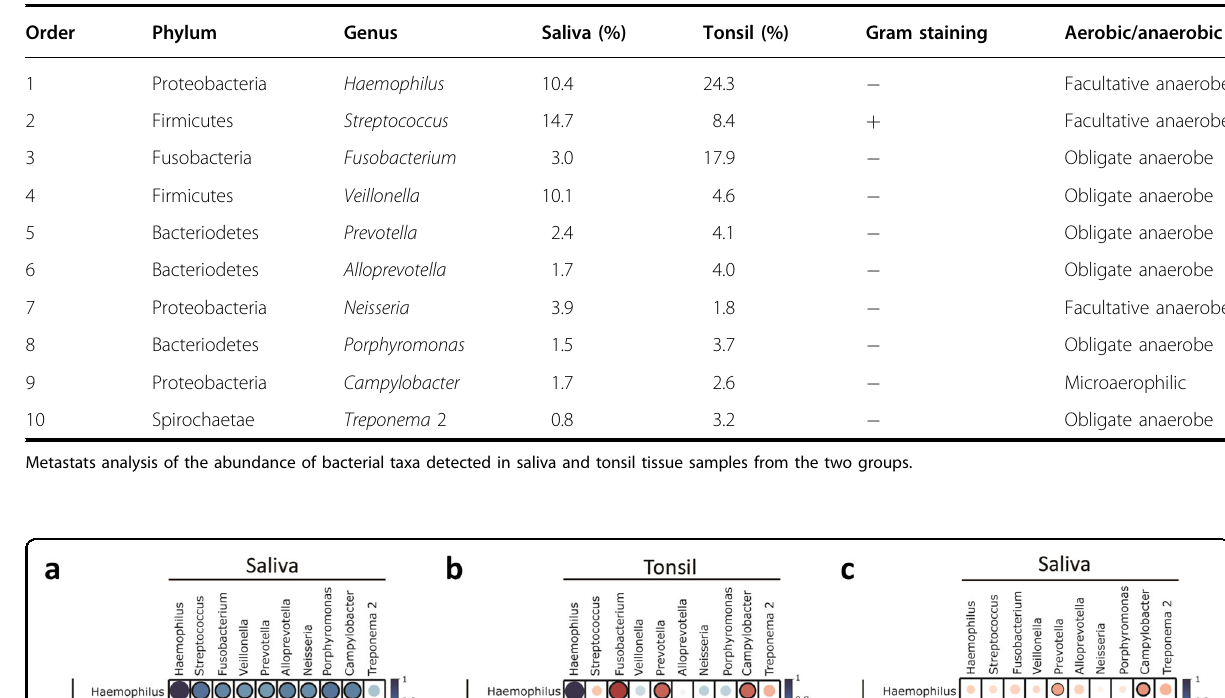
Table 3 Top 10 microbes ranked by Metastats analysis.